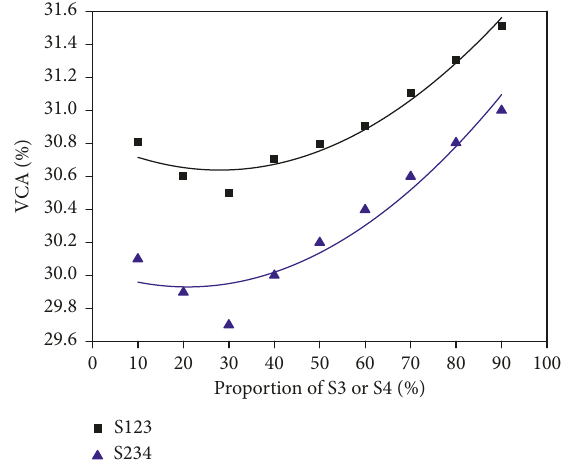
Figure 14: Influence of the content of secondary aggregate on the VCA.